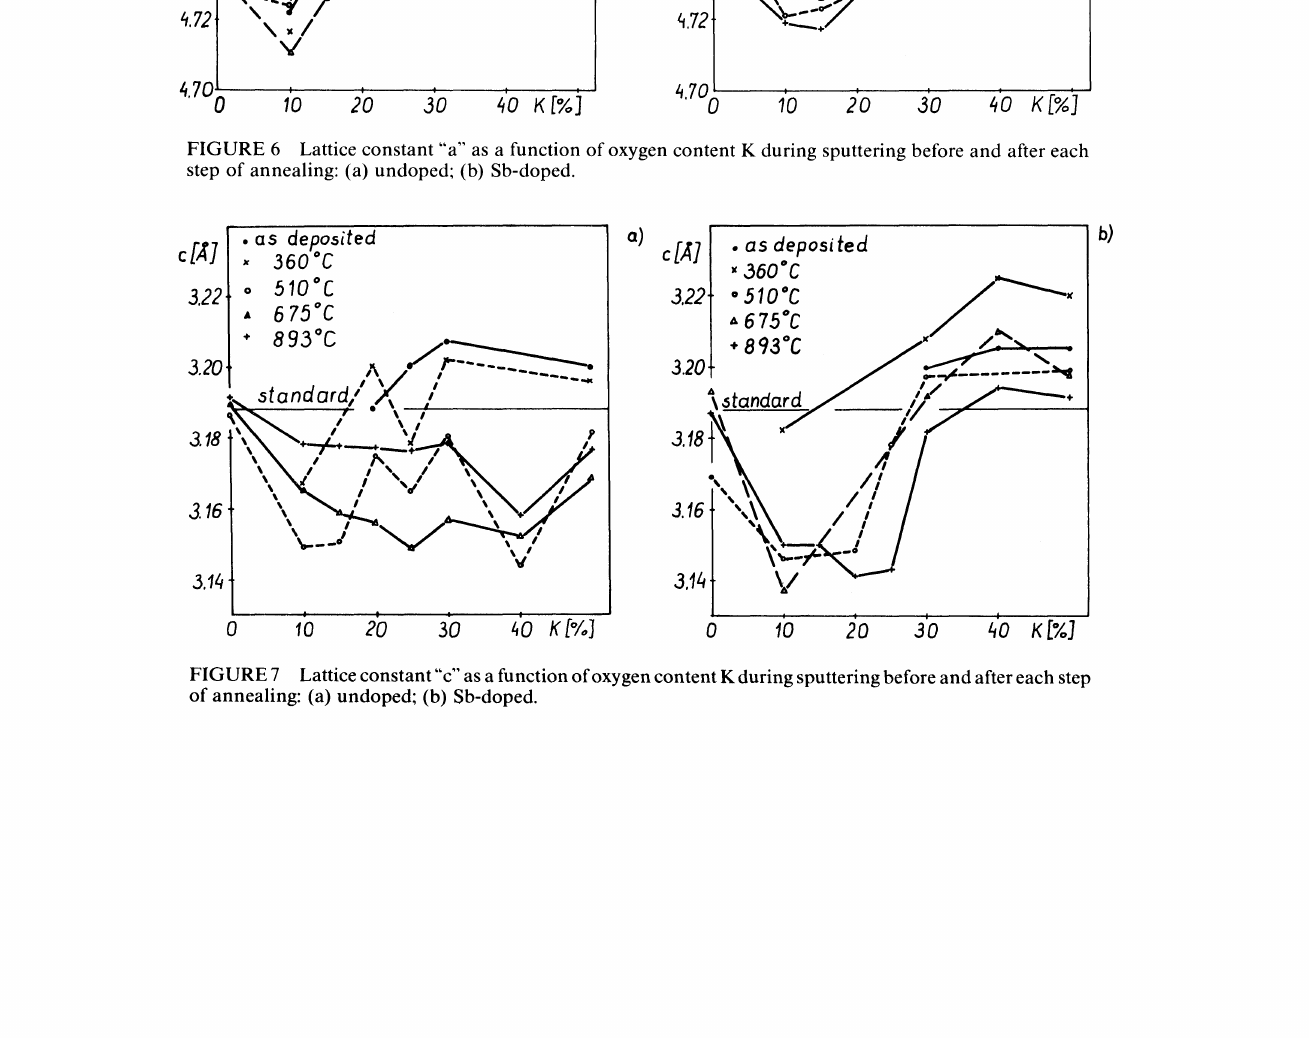
FIGURE 7 Lattice constant"c" as a function of oxygen content K during sputtering before and aftereach step of annealing: (a) undoped; (b)